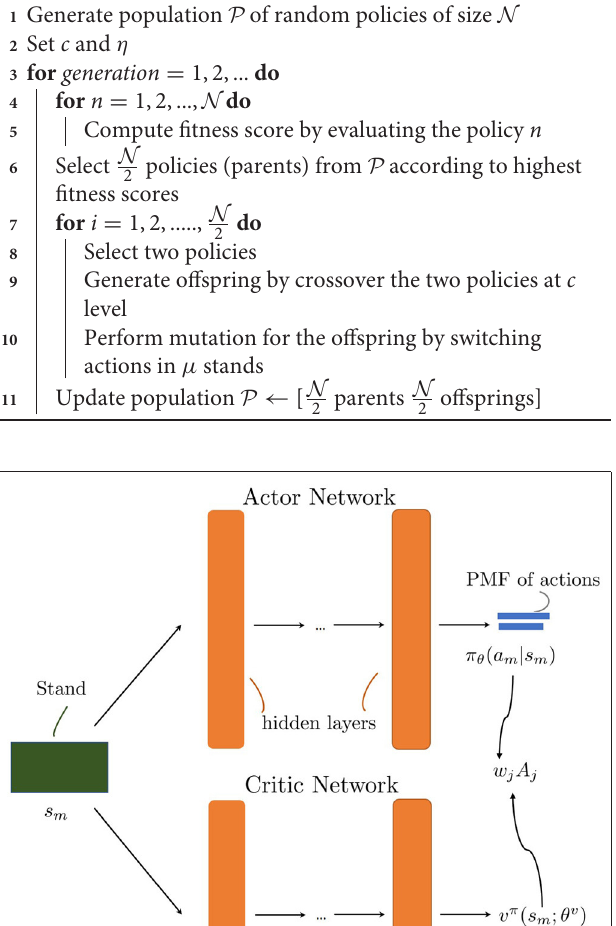
as shown in Figure 2 . The actor network updates the policy distribution and learns the optimal policy through the policy gradients. The networks are trained separately and update their relevant weights at each step.